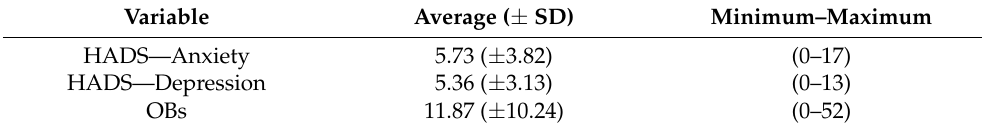
Table 4. Frequency of anxiety, depression, and OBs in the sample